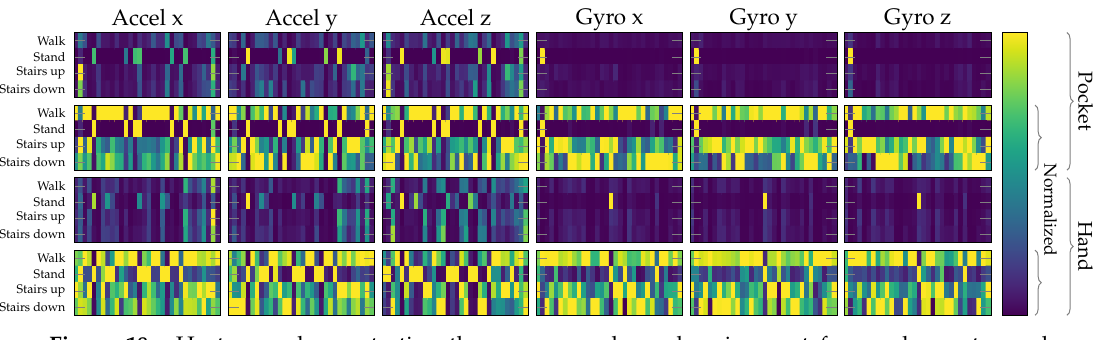
Figure 18. Heatmaps demonstrating the average codeword assignment for accelerometer and gyroscope data of pocket-case and hand-case, on a codebook of size 32 broken down by activity. The upper row for each case shows the unnormalized assignment averages, while the respective second lines were normalized per codeword (per column, across all activities). This allows to see tendential differences between activity-specific assignments, without losing sight of the real significance of